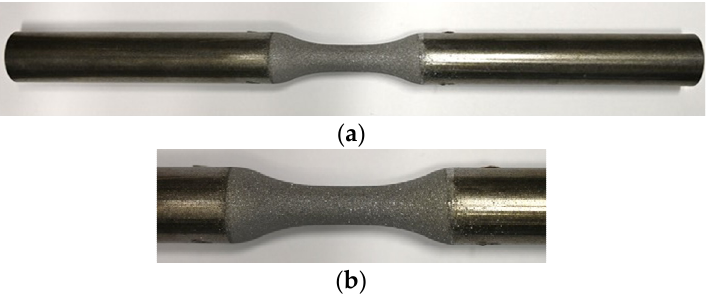
Figure 2. Macro images of sandblasted (I) specimen, ( a ) overview, ( b ) detail of gauge length.